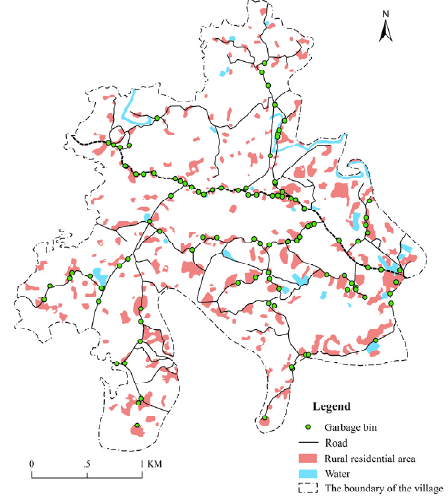
Figure 3. Distribution of garbage bins in Yuding Village.